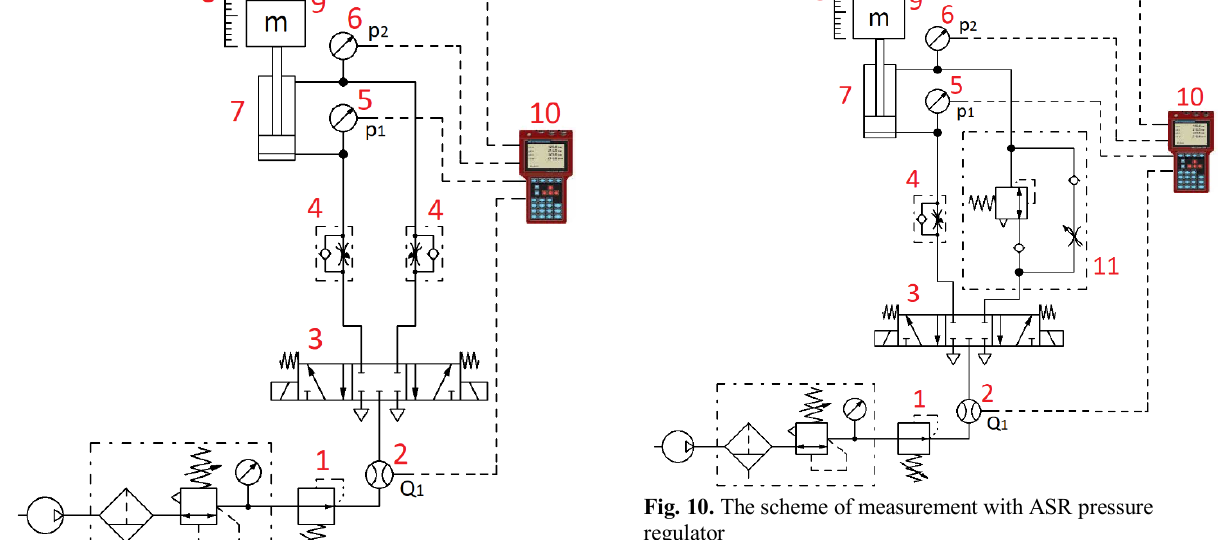
Fig. 9. The scheme of measurement with interruption of air supply 1 – reduction valve, 2 – flow meter, 3 –directional control valve, 4 – throttle and check valve, 5 – pressure 𝑝 6 –, pressure 𝑝 sensor 7 – pneumatic cylinder (linear motor), 2 8 – position sensor, 9 – mass load, 10 - measuring equipment M5050